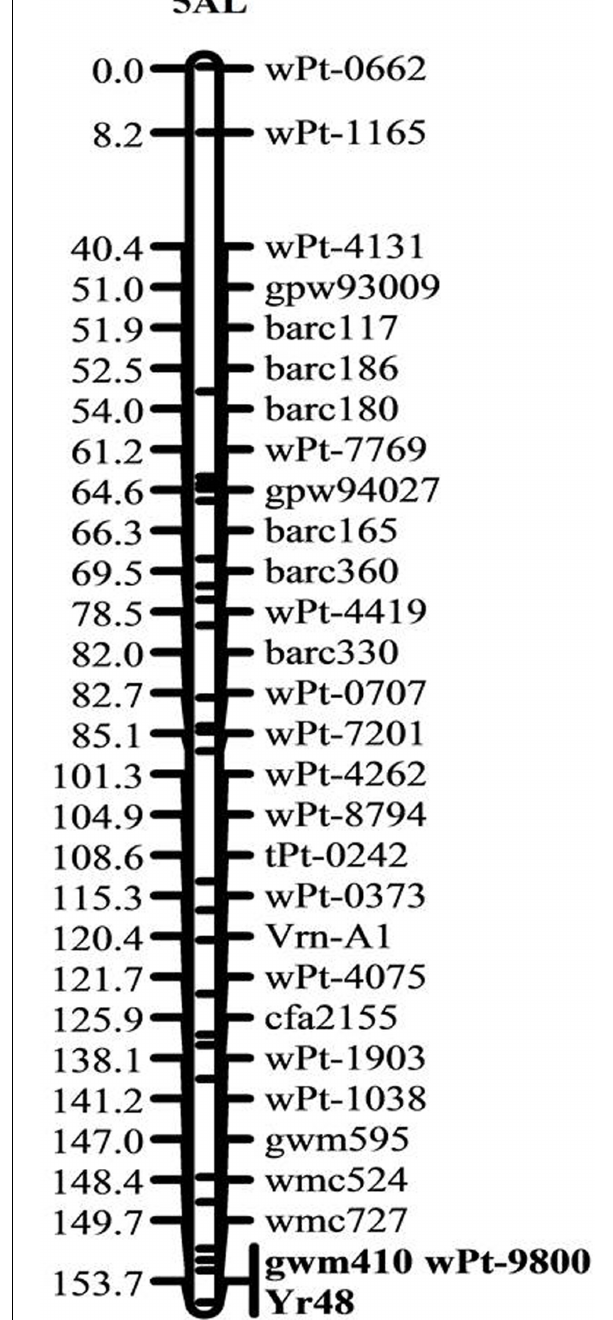
was 0.66 for YR severity over the 2 years ( Table 1 ). Low and severities ( r = 0.03–0.25) across all